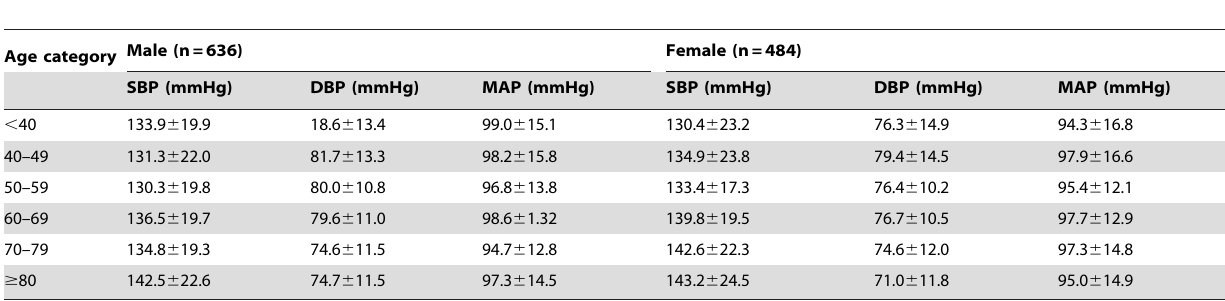
Table 2. The distribution of systolic blood pressure (SBP), diastolic blood pressure (DBP), and mean arterial pressure (MAP) separated by age and gender.